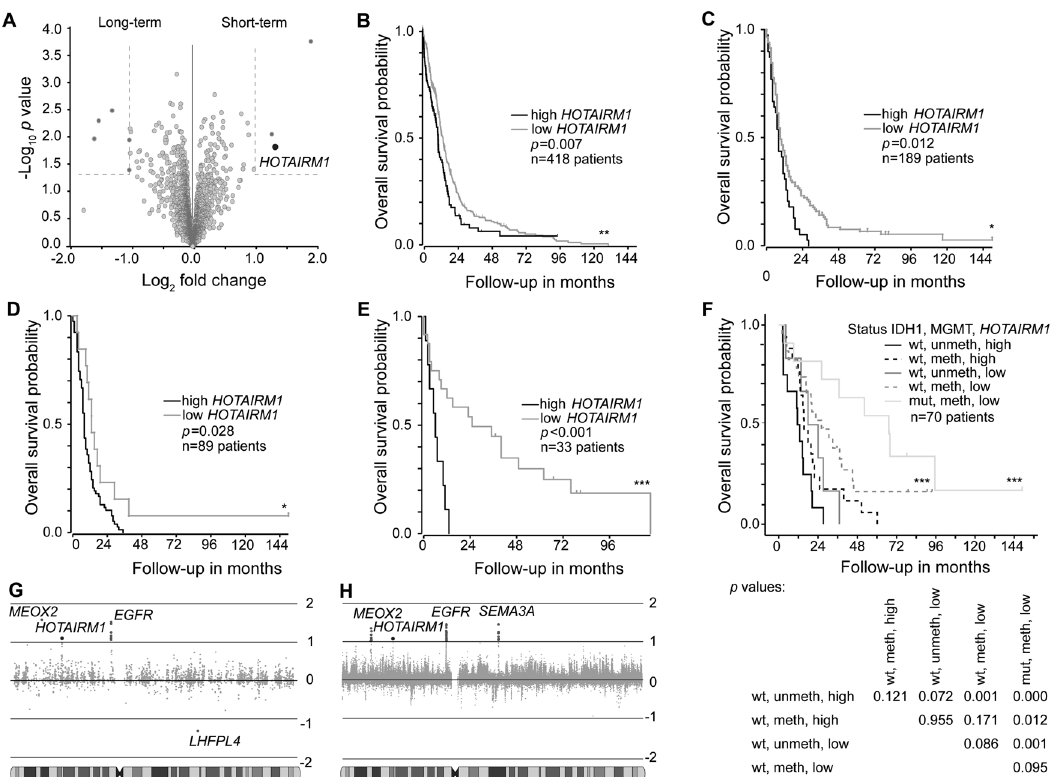
Fig. 1 Prognostic role of HOTAIRM1 expression in glioblastoma patient datasets. A Volcano plot showing differential expression of lncRNAs in glioblastomas from patients with long-term (overall survival > 36 months) versus short-term (overall survival < 12 months) survival in the German Glioma Network (GGN) cohort 24 . The black circle highlights HOTAIRM1 while dark gray circles represent other lncRNAs with differential expression between survival groups (±2-fold change and p < 0.05). Light gray circles indicate lncRNAs that are not signi fi cant. B Overall survival plots of glioblastoma patients from TCGA [34] (https://www.cancer.gov/tcga) and C Gravendeel et al. [35] strati fi ed according to high or low HOTAIRM1 expression levels. Cut-off for high HOTAIRM1 was determined by upper quartile and log rank statistics were